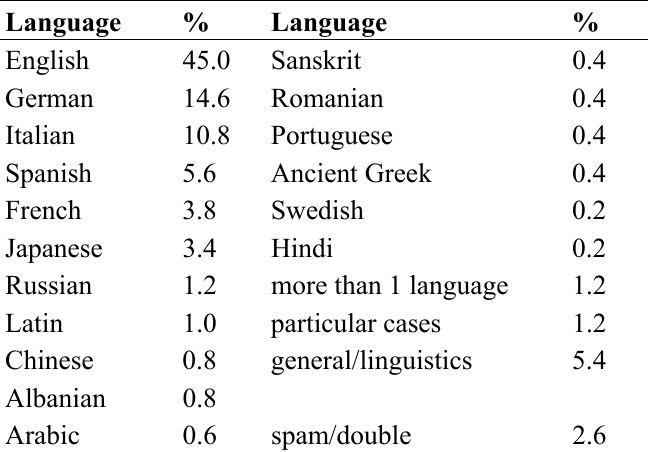
Table 1. Languages addressed in the considered